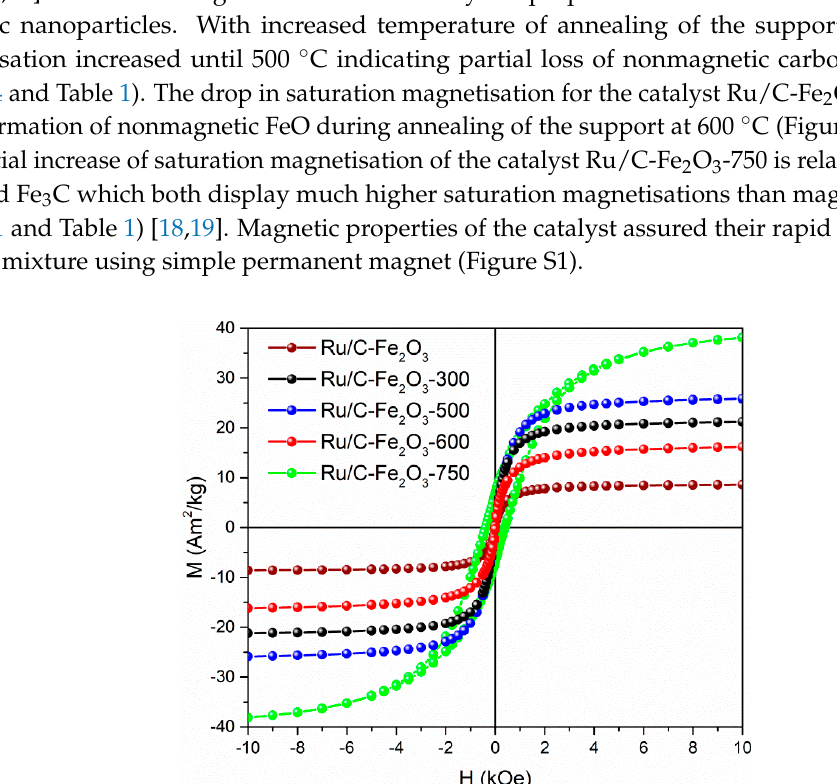
Figure 3. Empirical size distribution of functions of Ru nanoparticles fitted with Gaussians for the catalysts Ru/C-Fe 2 O 3 , Ru/C-Fe 2 O 3 -500, Ru/C-Fe 2 O 3 -600, Ru/C-Fe 2 O 3 -750, and log-normal distribution function for the catalyst Ru/C-Fe 2 O 3 -300.